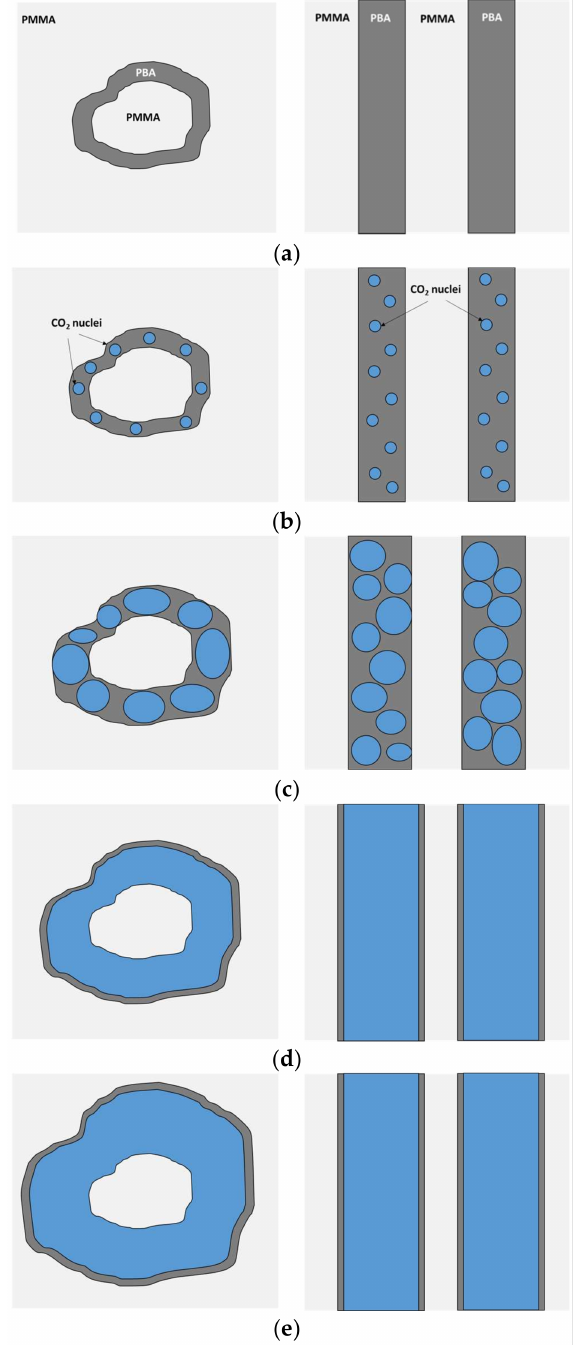
Figure 8. Scheme of the nucleation and cell growth process in the 90/10 (left) and 25/75 (right) PMMA/MAM nanostructures: nanostructure description ( a ); cell nucleation on the PBA phase ( b ); nuclei grow inside the PBA phase and expansion of the PMMA matrix surrounding the PBA phase ( c ); nuclei coalescence inside the PBA phase while the PMMA matrix keeps expanding ( d ); stabilization of the cellular structure ( e ). PMMA, PBA, and CO 2 phases are depicted in light gray, dark gray, and blue,